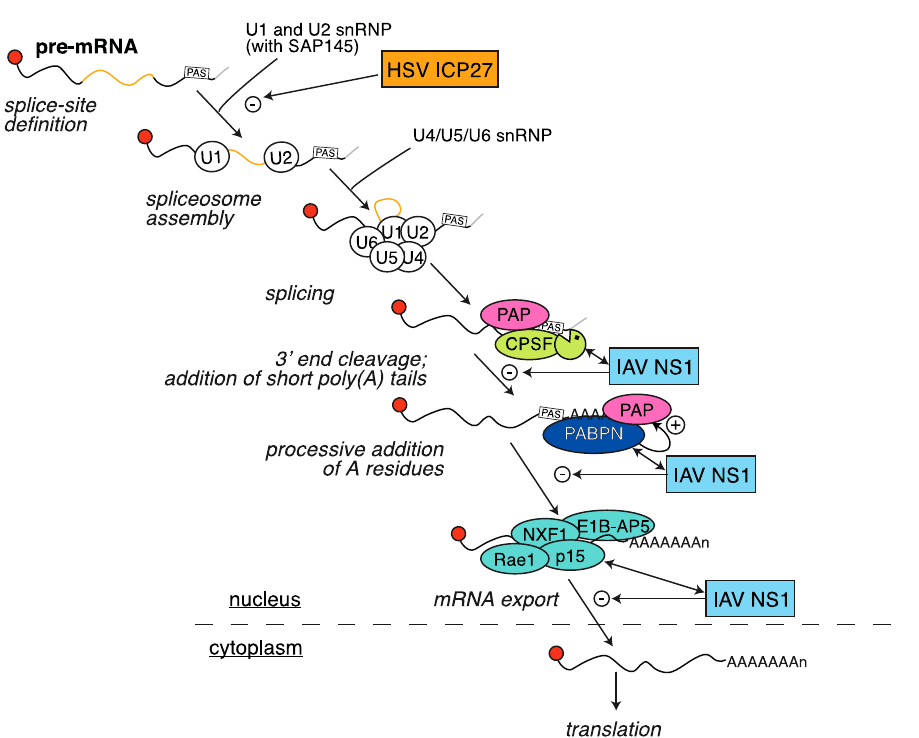
Figure 3. HSV ICP27 and IAV NS1 block mRNA processing. Newly transcribed pre-mRNAs are processed by splicing, that is the removal of introns (in yellow) through the action of the spliceosome complex. HSV ICP27 blocks the first step of complex assembly at splice sites. The pre-mRNAs are also processed at their 3 ′ end by the cleavage and polyadenylation complex (CPSF), which cleaves the RNA downstream of the polyadenylation signal (PAS) and allows poly(A) polymerase (PAP) to add short poly(A) tails. Nuclear PABPN is then required for stimulation of processive PAP activity and addition of the full-length poly(A) tails. IAV NS1 interferes with both steps of the process. For simplicity, splicing and 3 ′ end processing are represented in sequence, but they may occur simultaneously and also in part co-transcriptionally. IAV NS1 also interacts with components of the nuclear mRNA export complex (NXF1, p15, Rae1 and E1B-AP5) and blocks mRNA export.